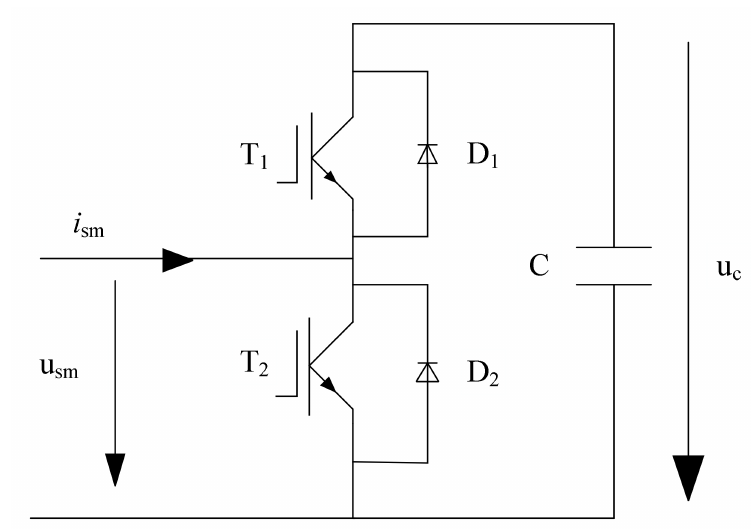
Figure 2. Circuit model of MMC